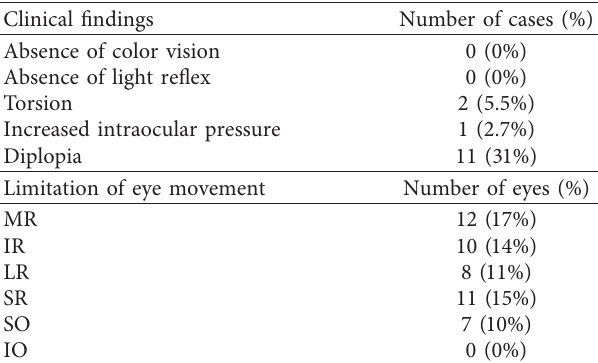
Table 1: Baseline ophthalmological findings of GO patients. Clinical